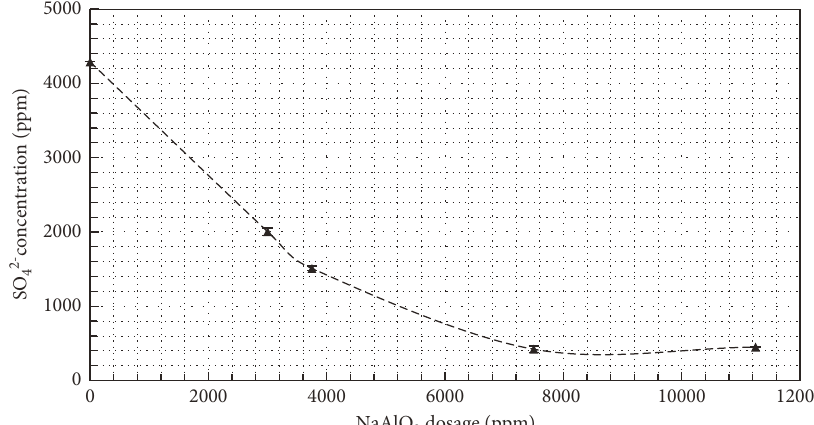
2 at a fixed Al: Ca molar ratio of 1 :3. The RSD of